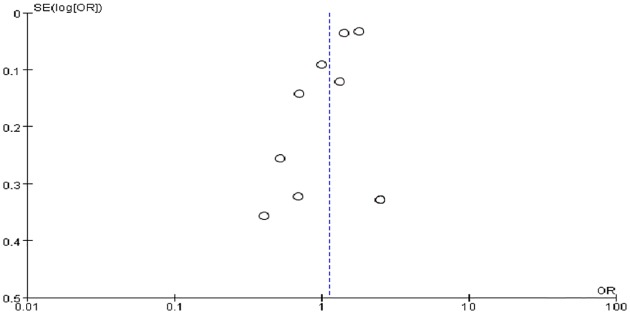
Funnel plot showing publication bias of any stage retinopathy of prematurity and hypertensive disorders in pregnancy.